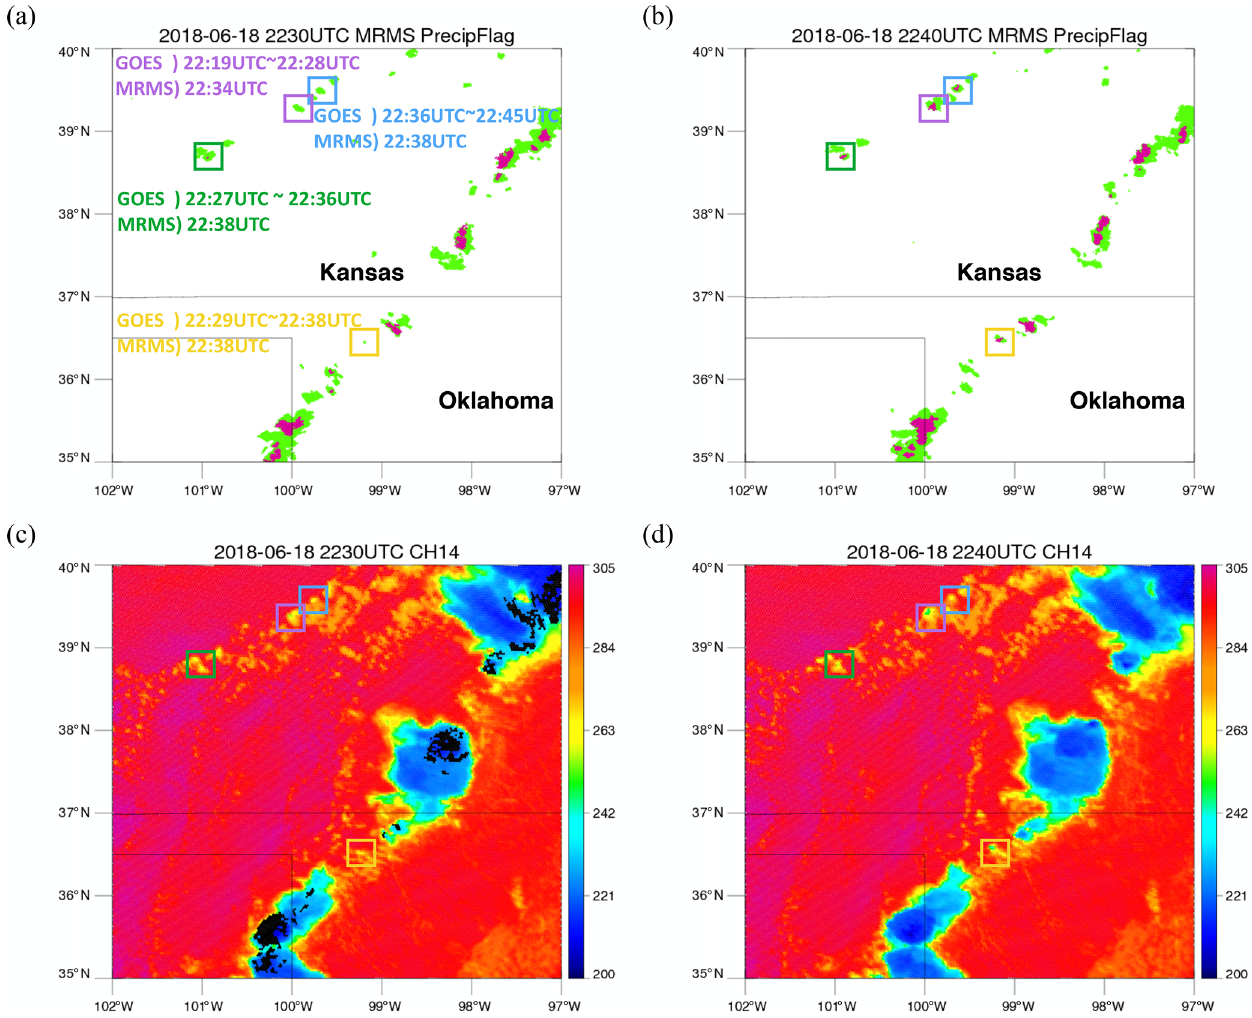
Figure 7. (a) MRMS PrecipFlag at 22:30UTC on 18 June 2018. Pink represents convective while green represents stratiform. Times next to each box represent the times of GOES data used in the growing cloud detection method and time of detection by MRMS. (b) MRMS PrecipFlag at 22:40UTC on 18 June 2018. (c) GOES-ABI 11.2µm infrared channel imagery (K) at 22:30UTC on 18 June 2018 over the Great Plains. (d) Same as (c) , but at